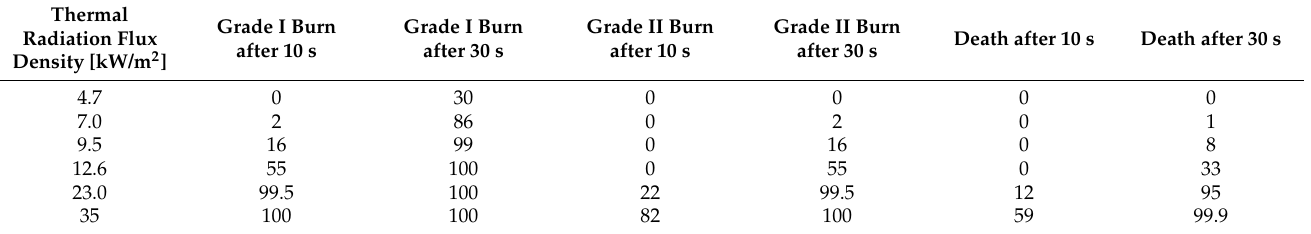
Table 2. Likelihood of occurrence of a specific type of injury suffered by persons due to exposure to thermal radiation for 10 s and 30 s caused by jet fire or pool